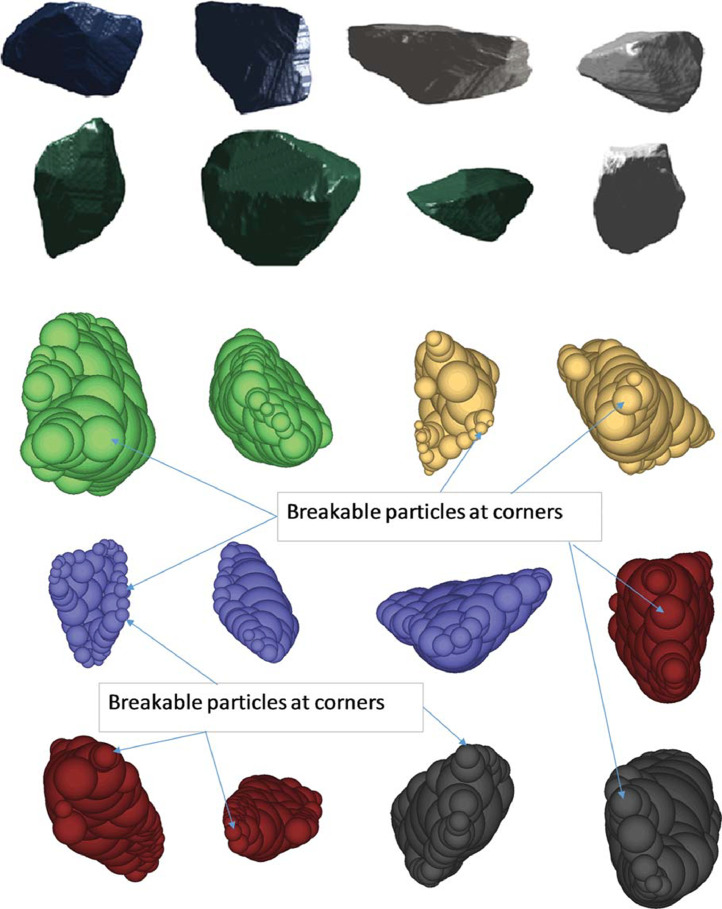
Example of digitized ballast samples (top) and simulated ballast particle shapes used in DEM (bottom) [10].